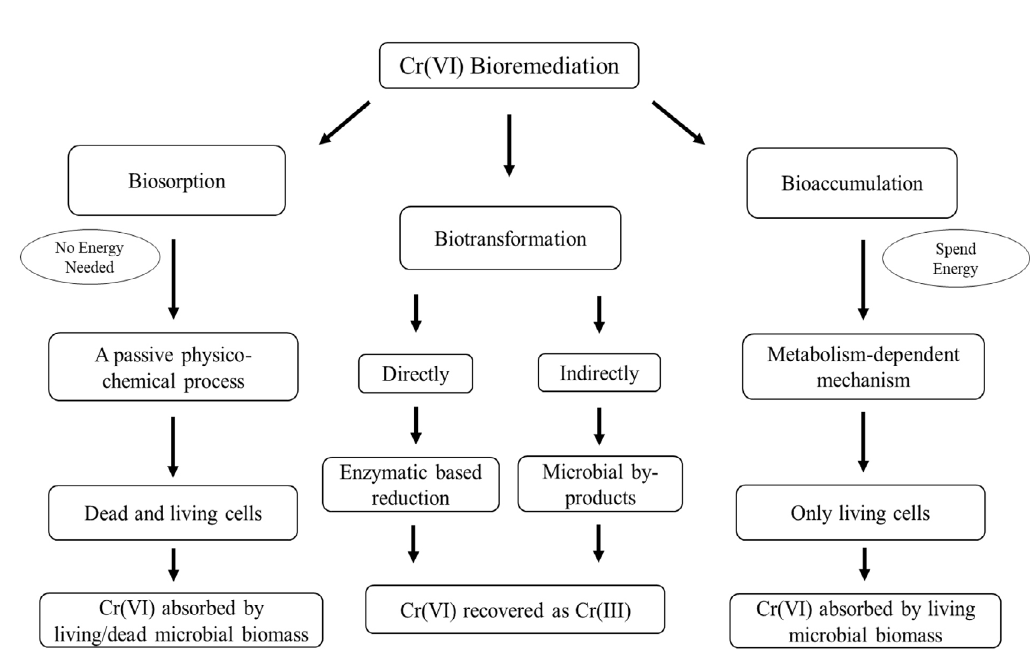
Fig. 2. Schematic illustration of the three Cr(VI) bioremediation